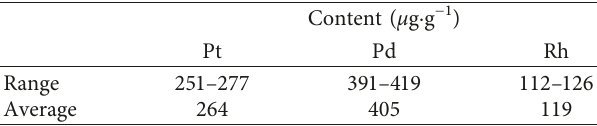
Table 1: Elemental analysis of Pt, Pd, and Rh of the spent catalyst unit under